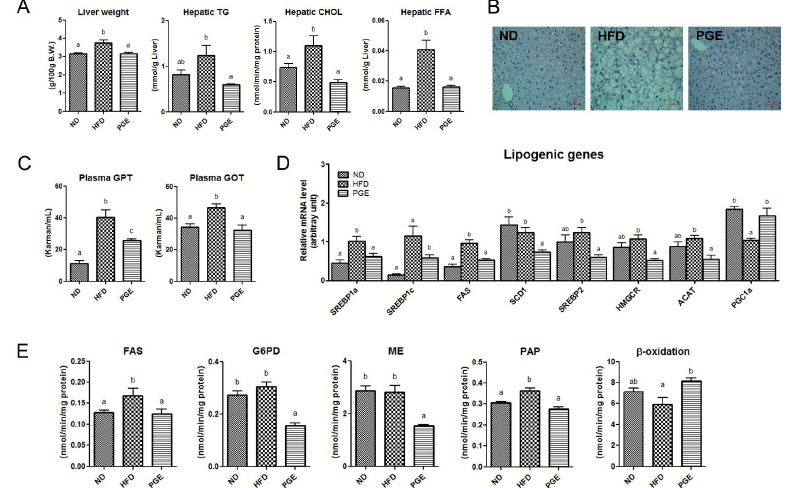
Figure 3. Effects of PGE treatment on hepatic steatosis ‐ related markers in HFD ‐ fed C57BL/6J mice. The data are the mean ± SEM ( n = 10). ( A ) The weight of the liver and plasma levels of hepatic cholesterol, TG, and FFA; ( B ) hematoxylin and eosin (H & E) ‐ stained transverse sections of the liver, 1000× magnification; ( C ) levels of the hepatic lipotoxicity markers GOT and GPT; ( D ) Lipogenesis ‐ related gene expression; and ( E ) Hepatic lipid ‐ regulating enzyme activities in the HFD ‐ fed mice. ND, mice fed a normal diet; HFD, mice fed a high ‐ fat diet (HFD) alone; PGE, Platycodon grandiflorus root extract (5%, w / w ) ‐ treated HFD ‐ fed mice.